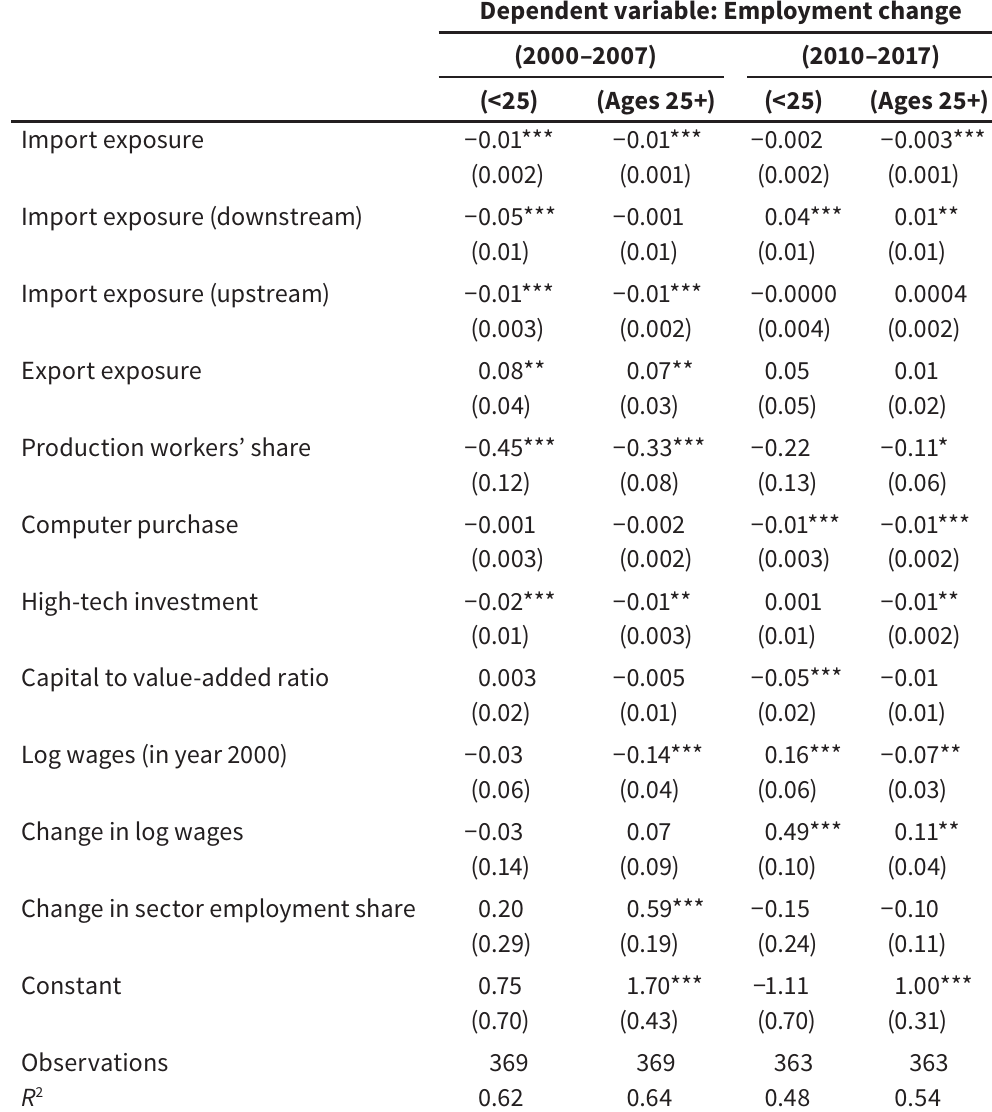
Main results: Employment and trade shocks Dependent variable: Employment